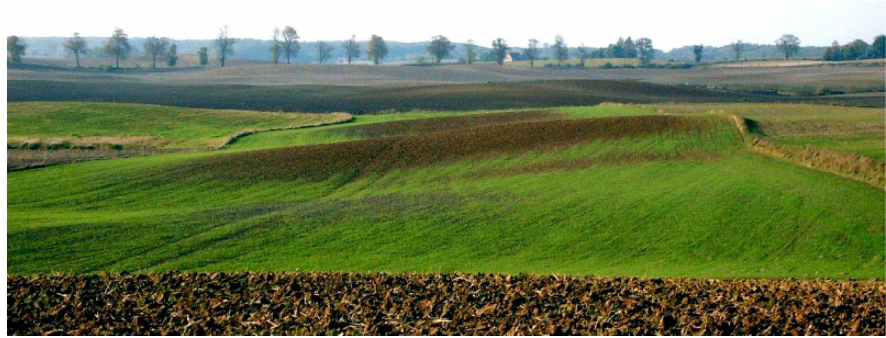
Figure 5. The weaker wheat growth fully coincides with the extent of eroded soils with ABtp and ACkp surface horizons (groups A and